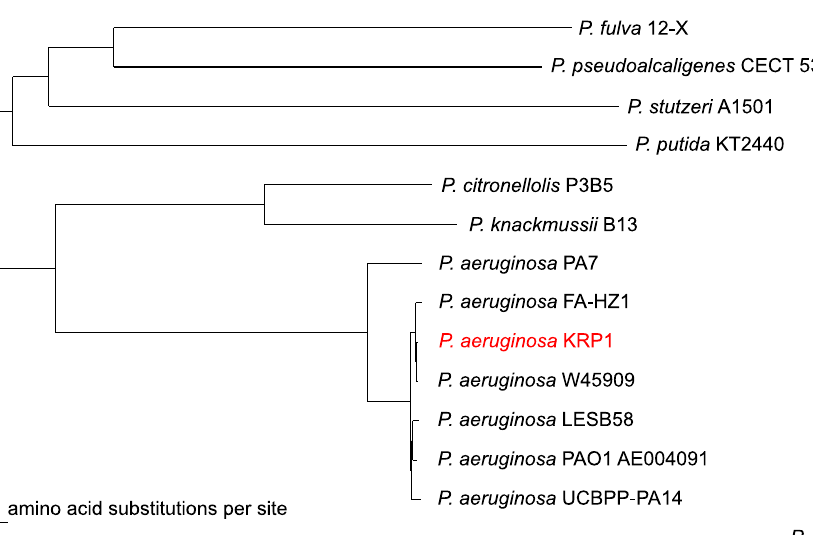
Figure 1. Phylogenetic tree of six fully sequenced P. aeruginosa strains and eight other Pseudomonas species. The tree was calculated using the EDGAR platform 24,25 out of a core of 1,537 genes per genome comprised of 532,537 amino acid-residues per